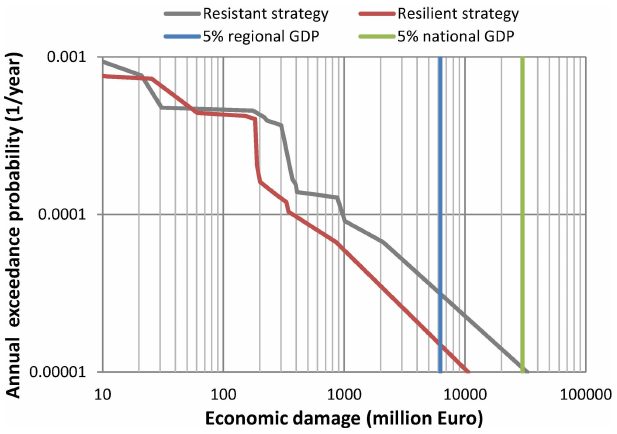
Fig. 5 . Economic risk for the resilient strategy (red line) and the resistant strategy (grey line), with the recovery threshold of 5% of regional GDP (blue line) and national GDP (green line).